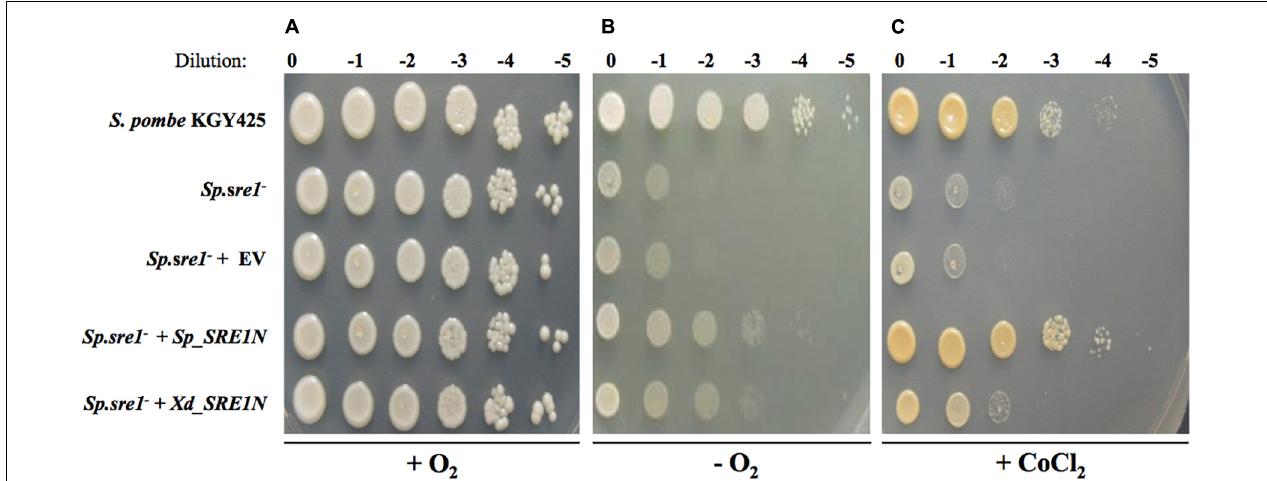
FIGURE 4 | Growth phenotype of S. pombe strains. Serial dilutions of cultures of S. pombe strains KGY425 (parental) , Sp.sre1 - , Sp.sre1 - + EV (empty vector) , Sp.sre1 - + Sp_SRE1N (vector expressing Sre1N from S. pombe ) and Sp.sre1 - + Xd_SRE1N (vector expressing Sre1N from X. dendrorhous ), were seeded on YES medium and incubated at 30 ◦ C under (A) normoxia for 3 days, (B) hypoxia using the AnaeroGen de Oxoid R (cid:13) anaerobiosis system for 10 days and (C) YES medium supplemented with cobalt chloride (1.6 mM) for 3 days. Dilution indicates no initial culture dilution (0) and dilutions 10 - 1 to 10 - 5 (–1 to –5).